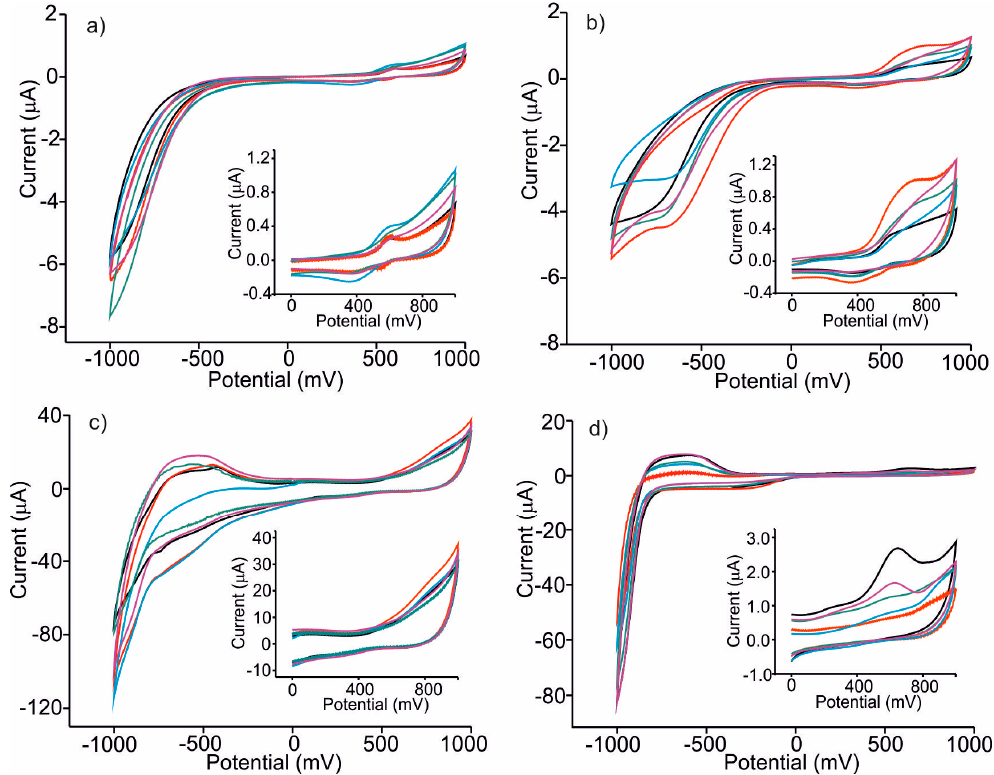
Figure 1. Cyclic voltammograms registered using CPEs immersed in nalewkas made from different varieties of apples. ( a ) Unmodified CPE; ( b ) ZnPc–CPE; ( c ) FePc–CPE; ( d ) CoPc–CPE Samples: Ligol (black), Kosztela (red), Grey Reinette (blue), Rubin (green), Cox Orange (purple).